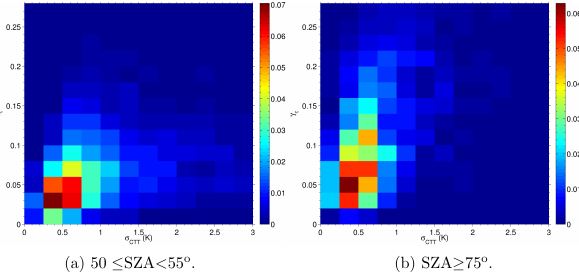
Figure 3: 2D histogram of two different heterogeneity parameters. Figure 13. 2-D histogram of γ τ vs. σ CTT for low (a) and high (b) θ 0